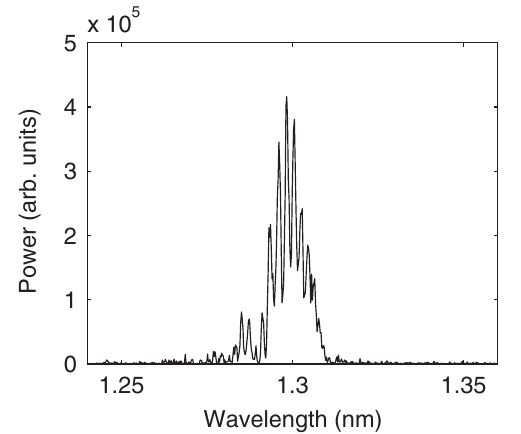
FIG. 6. Spectrum of a single FEL radiation pulse at 34.4 m for the case of an 800 nm modulating laser. The fringing in the spectrum is due to interference between the radiation emitted by the central and satellite peaks.